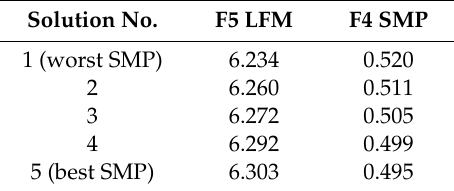
Table 9. Fitness functions for the pair F5–F4.